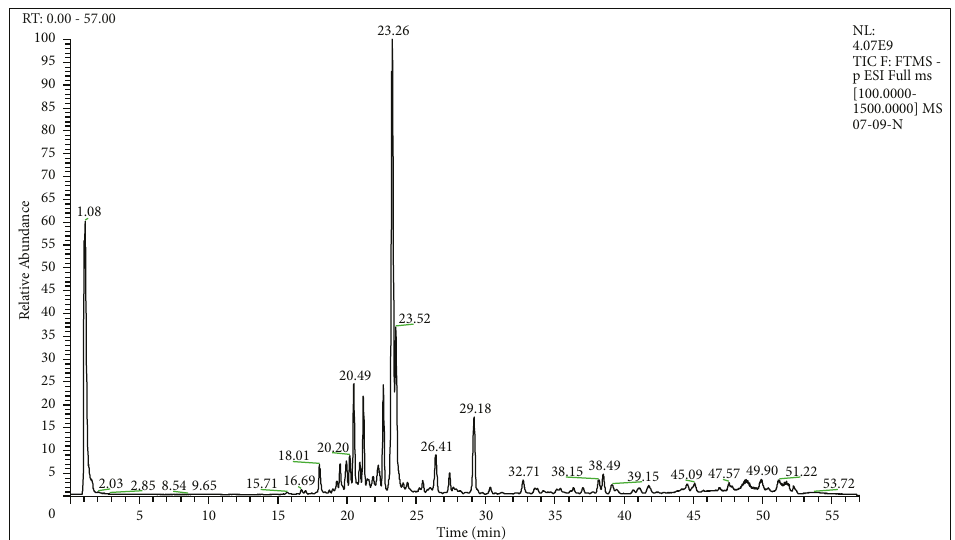
Figure 1: The total ion chromatogram of CEE analyzed by UHPLC-HRMS/MS in negative ion mode.